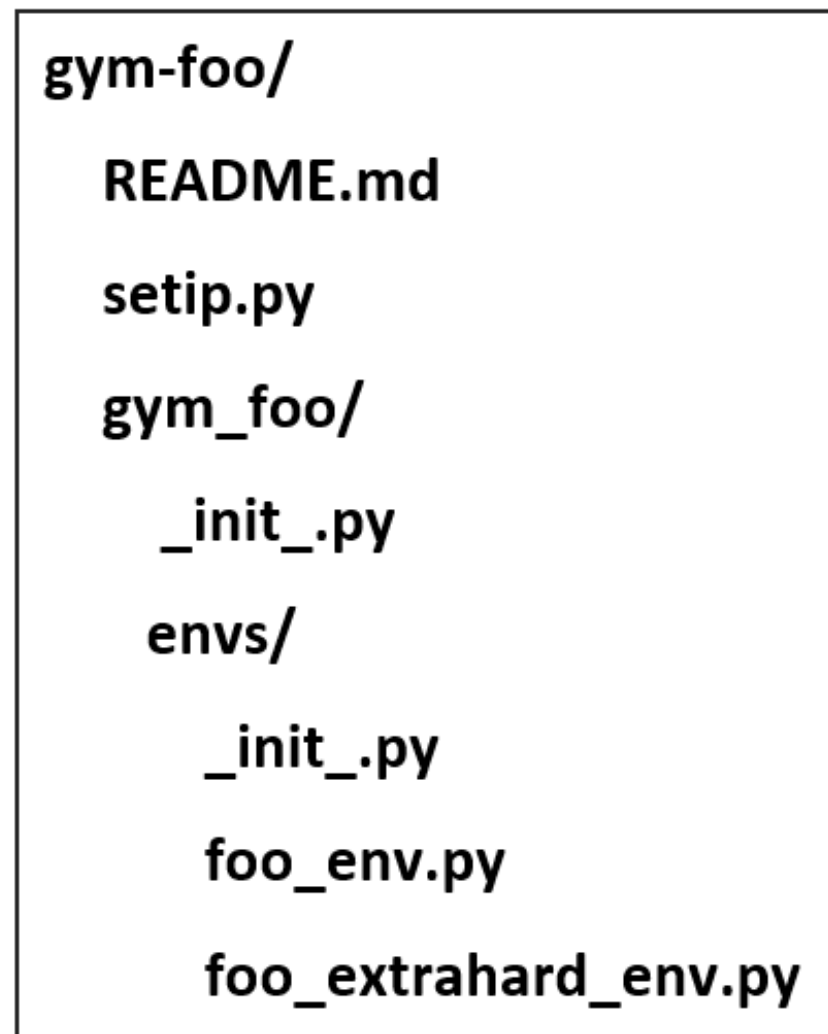
Figure 5. Custom OpenAI Gym implementation.